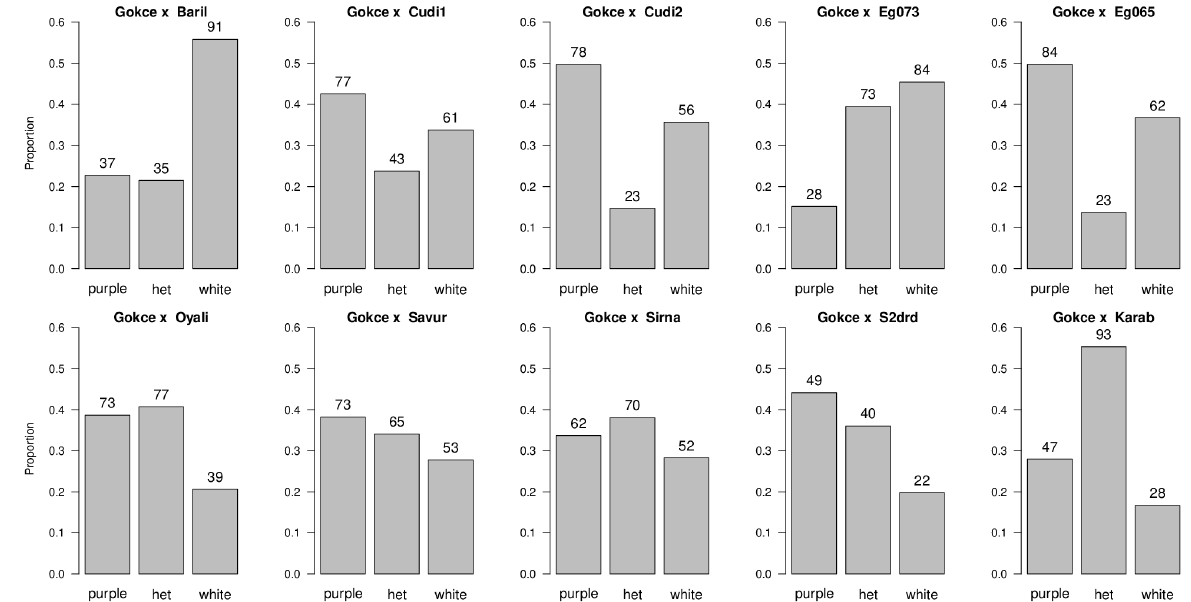
Figure 5. Frequency distribution of flower color in ten chickpea NAM populations. The het category means heterozygous mix of white and purple flowers. Bar heights are proportions and values above bars are counts.